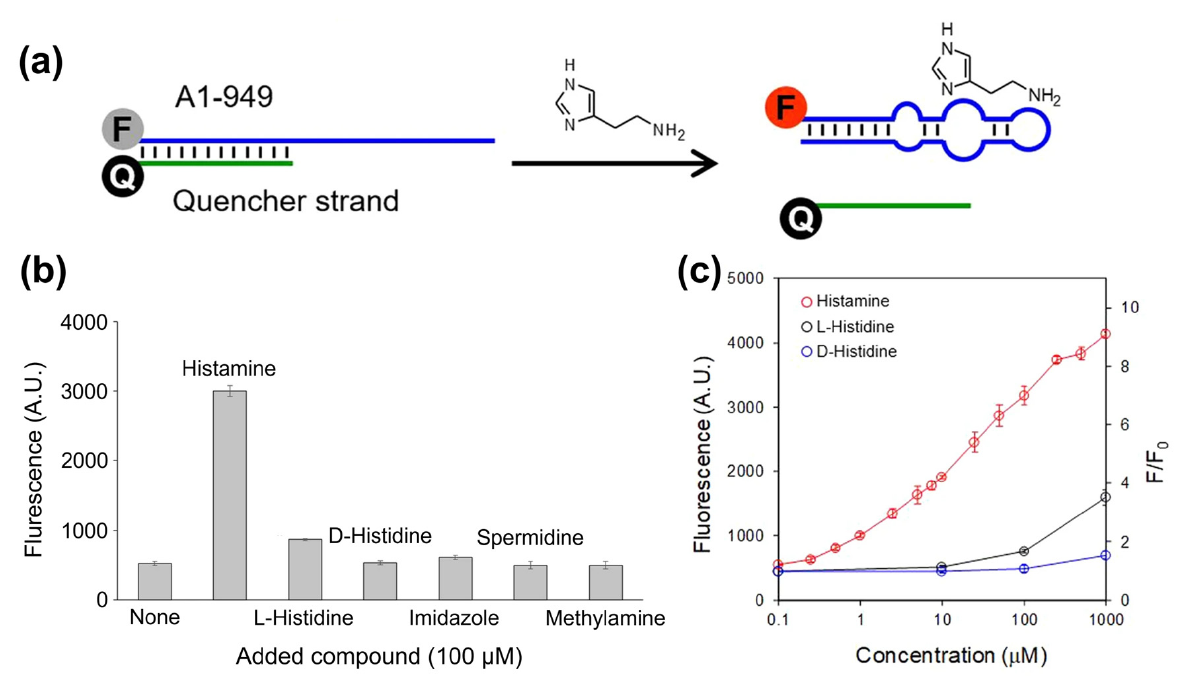
Figure 6. ( a ) Fluorescence-based assay for the detection of histamine in solution. The aptamer carries a Cy5 fluorophore at the 5 ′ terminus and is hybridized with a partially complementary quencher strand with a BHQ2 molecule at its 3 ′ location [142]. Recognition of histamine removes the quencher strand and the aptamer attains a new conformation, resulting in fluorescence emission. ( b ) The selectivity test reveals high affinity of the aptamer to histamine and reduced affinity to histidine and other biogenic amines, here for high concentrations of 100 μ M. ( c ) Up to target concentrations of 10 μ M, the response to the two histidine enantiomers is negligibly small. Figure adapted from ref. [142],